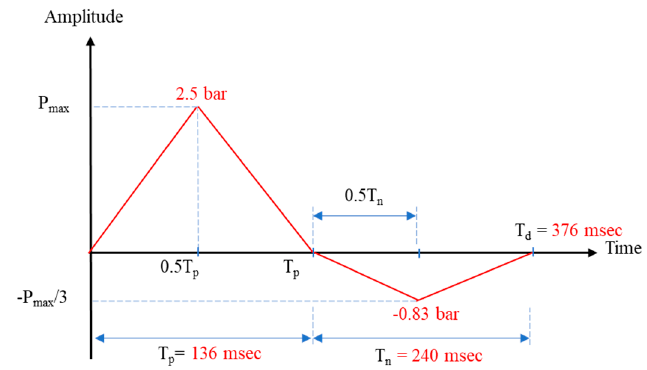
Figure 10. Dynamic pressure history .